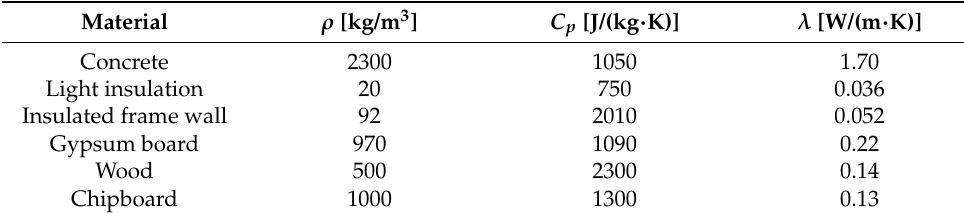
Table 4. Materials used in the office building model.